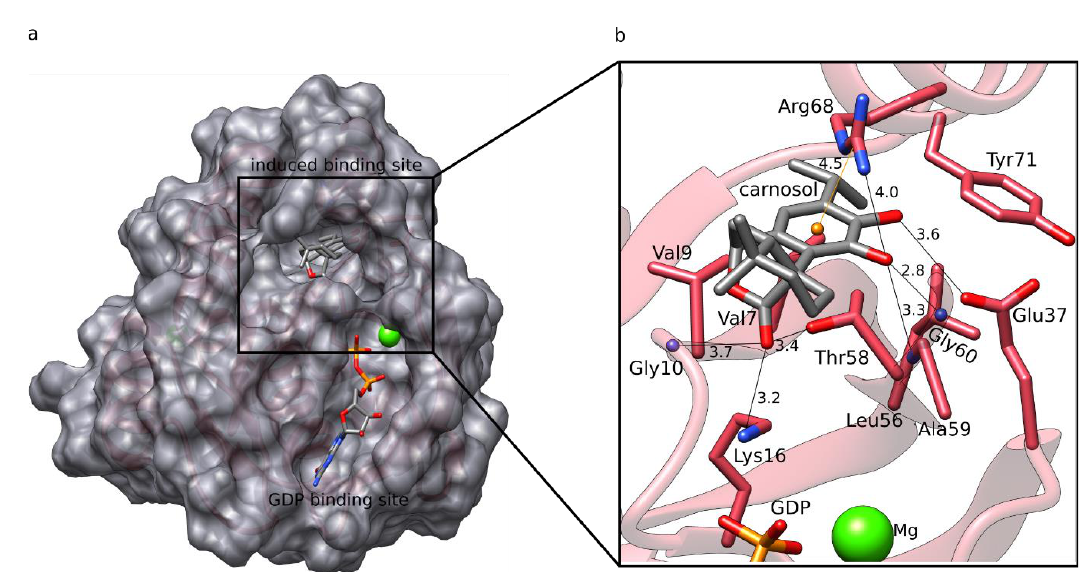
Figure 4. Overview of the docked complex with K-RAS. ( a ) K-RAS (pink ribbons and gray surface) with the depicted GDP binding site with GDP bound and the induced binding pocket with carnosol docked. Both ligands exhibit gray carbons. Magnesium ions are shown as green spheres. ( b ) The docked pose of carnosol in the induced binding site forms numerous hydrophobic interactions, as well as H-bonds (black line with distance in Å ). Moreover, it makes a cation –π stacking interaction with Arg68 (orange line). The figure is based on the crystal structure with the PDB ID 4LUC. Among the three diterpenes, carnosol exhibited the best docking score (Table S3).